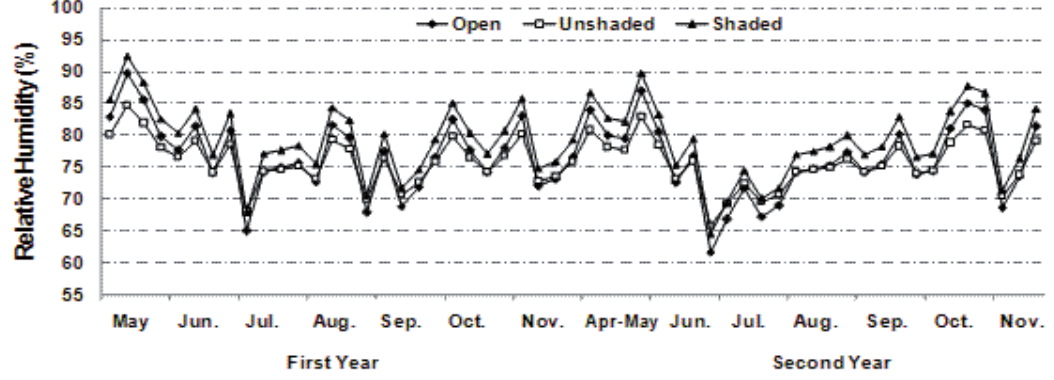
Fig. 3: The relative humidity data of nursery conditions with respect to